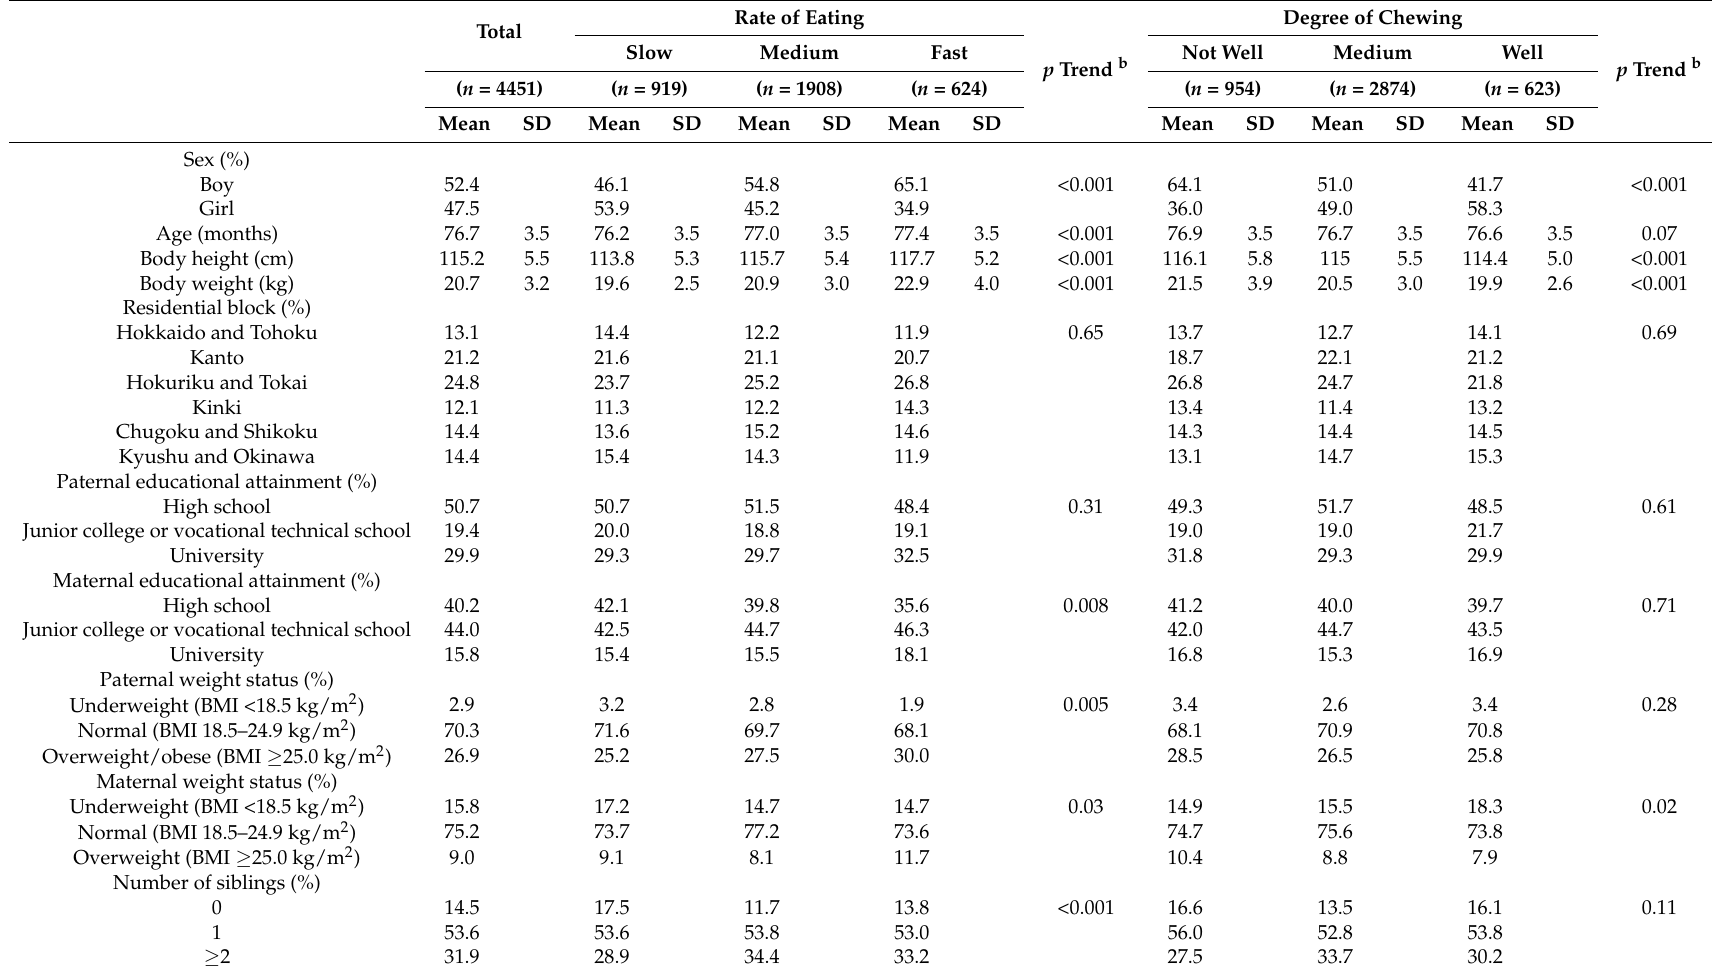
Table 1. Characteristics of subjects according to rate of eating and degree of chewing among Japanese preschool children a